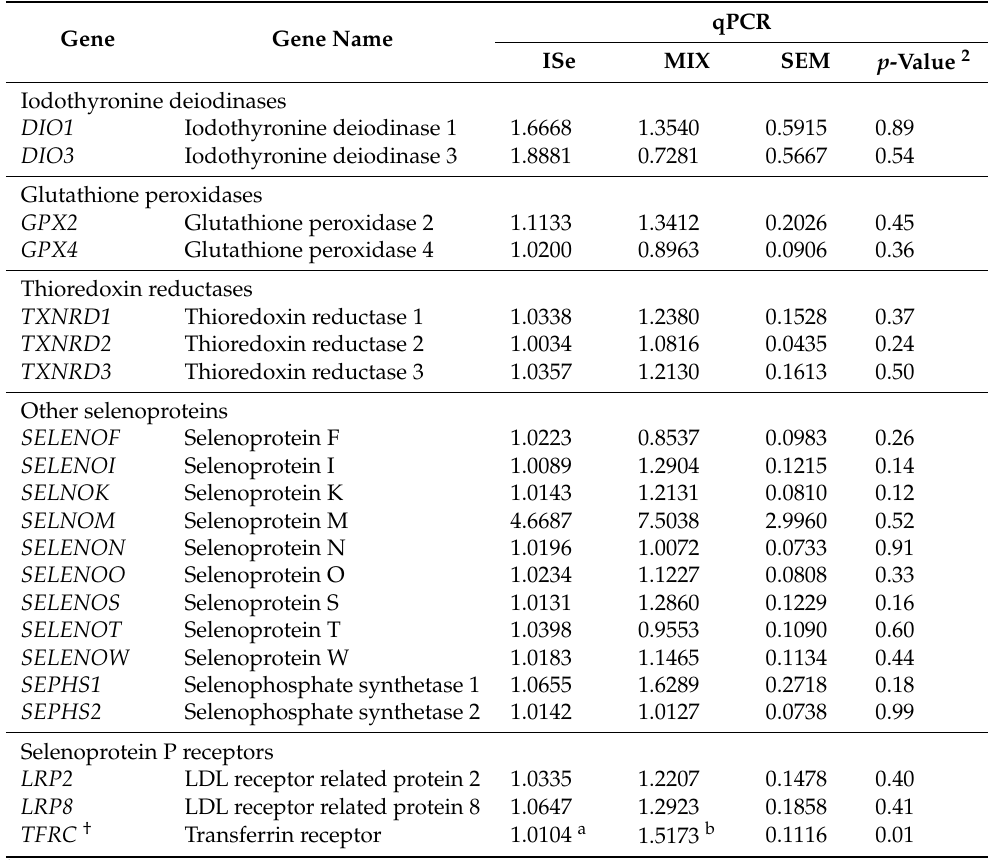
Table 1. Relative abundance of mRNA encoding selenoproteins and selenoprotein P receptors in the CL of cows supplemented with vitamin-mineral mixes containing Se as sodium selenite (ISe, n = 5) or a 1:1 equimolar mix of ISe and OSe (MIX, SEL-PLEX, n = 5) 1